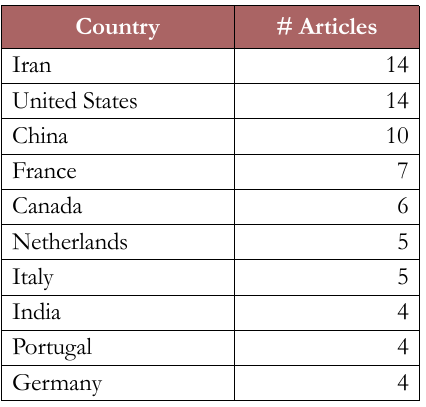
Table 8. Top 10 countries, based on the origin of the authors